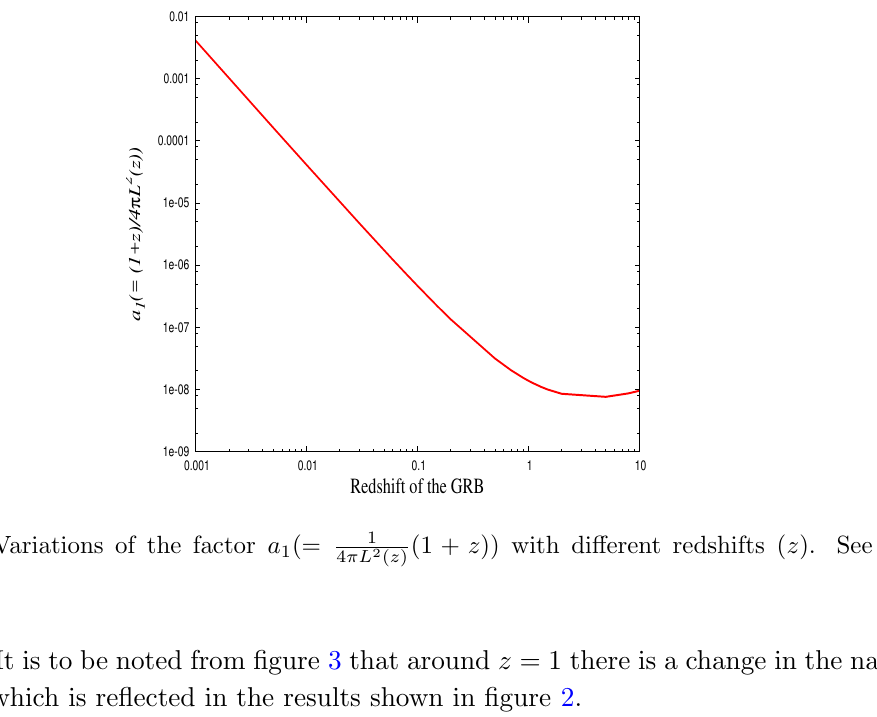
(1 + z )) with di(cid:11)erent redshifts ( z ). See text 4 (cid:25)L 2 ( z )